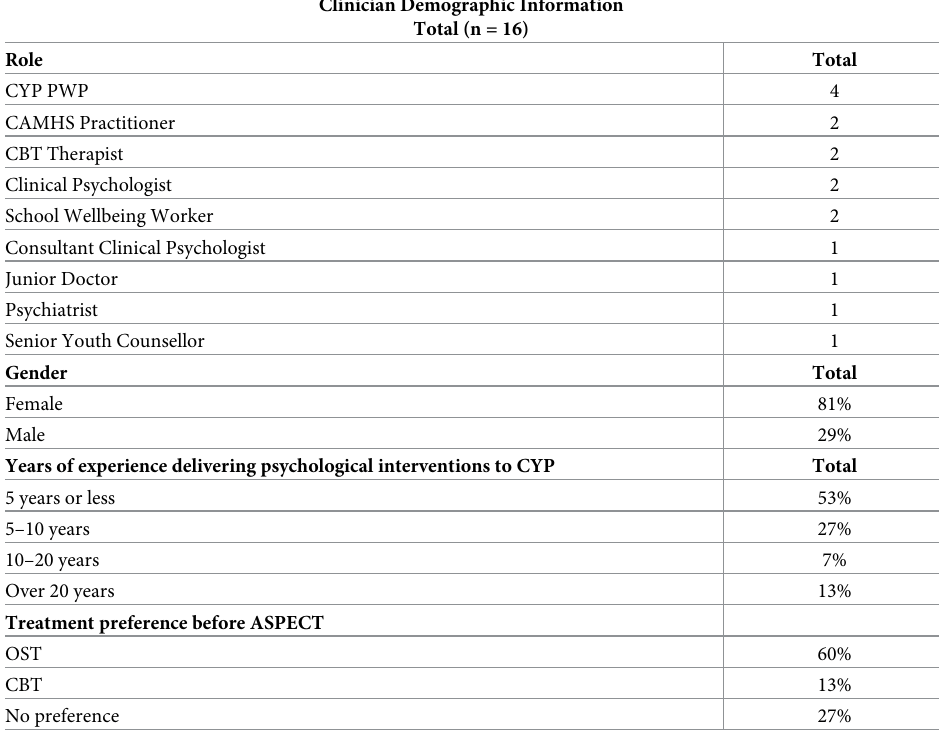
Table 3. Clinician demographic information.